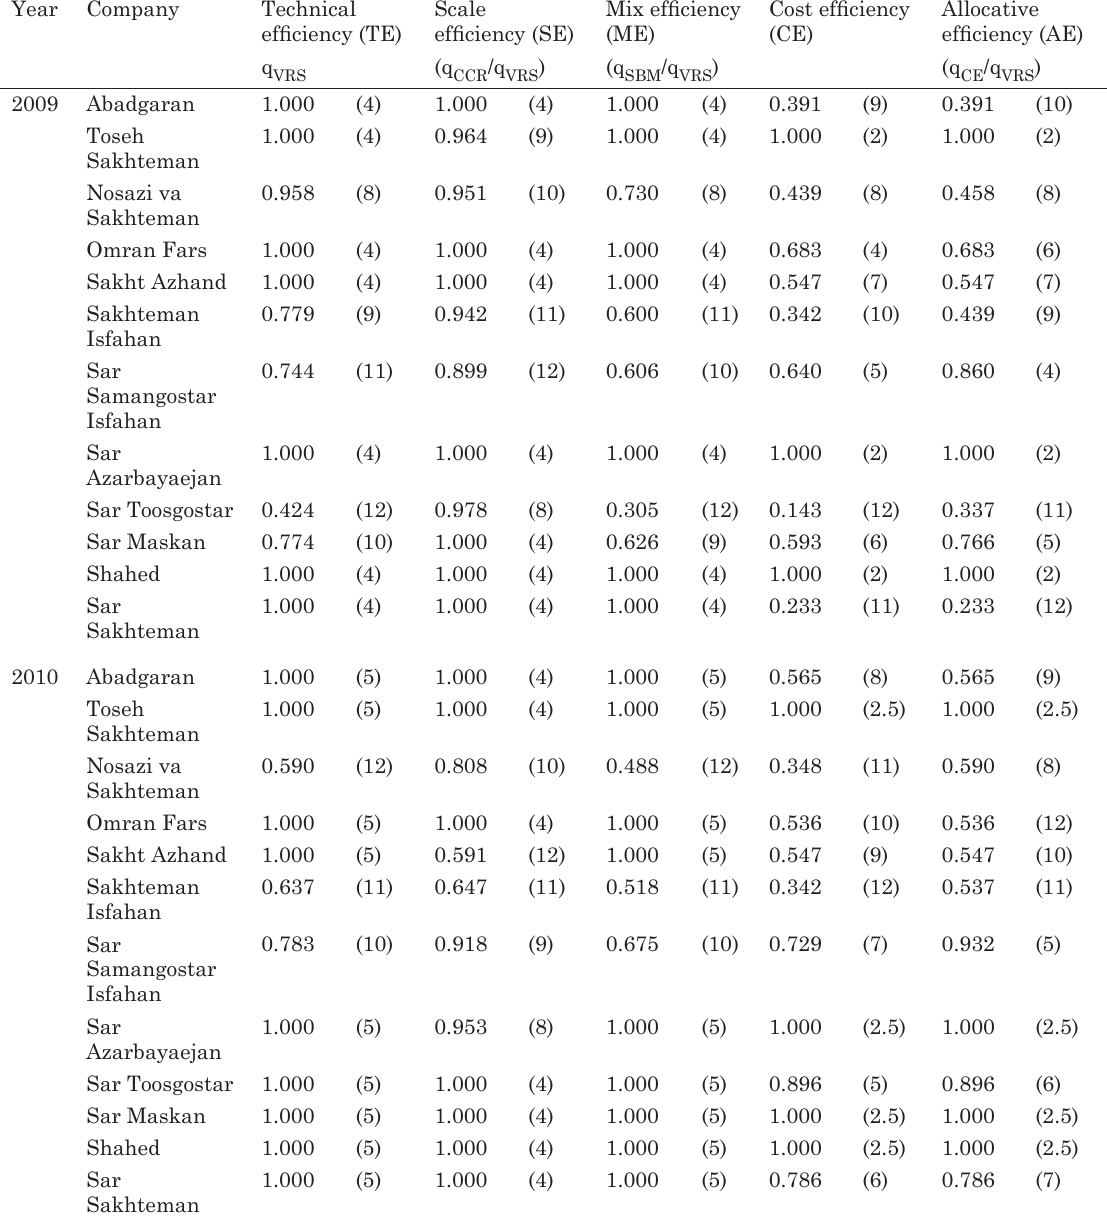
Table 2. Iranian real estate and construction companies DEA efficiency results without virtual company,